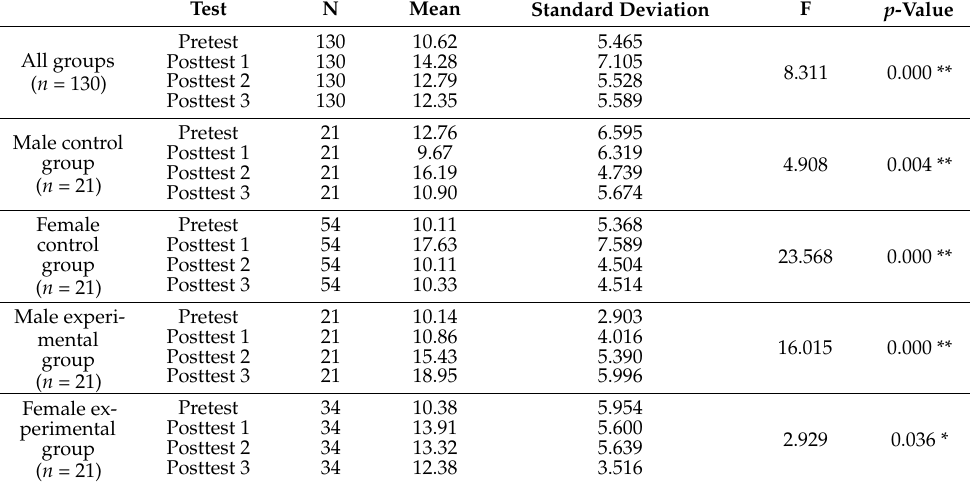
Table 5. ANOVA Results for the Differences Between all Tests Within all Groups.